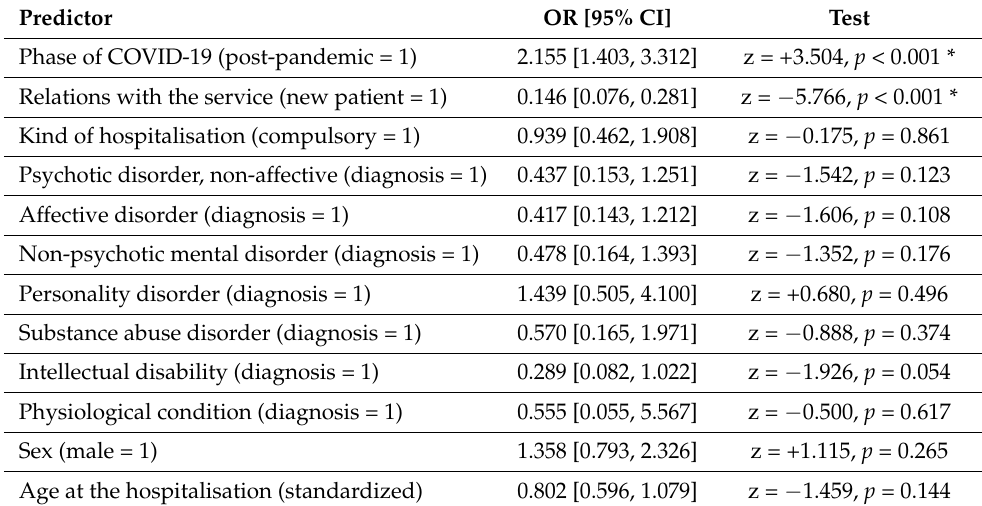
Table 2. Risk factors for revolving-door